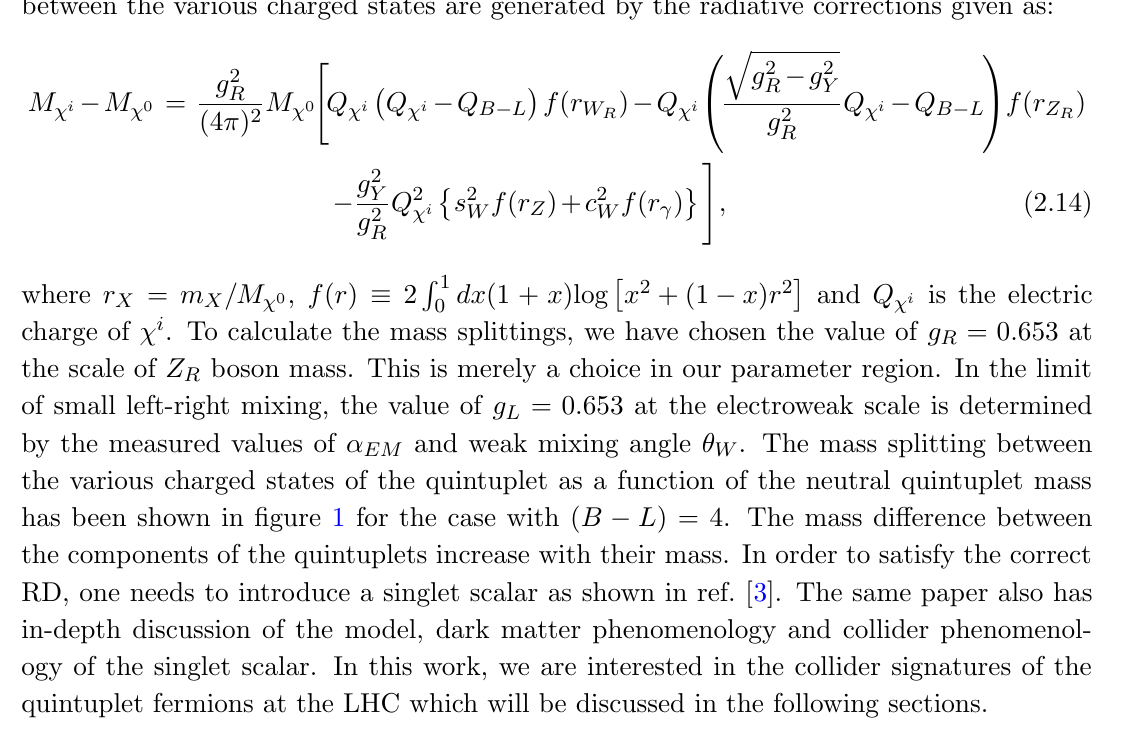
= 6 TeV and M Z = 7.14 TeV (see eq. R R